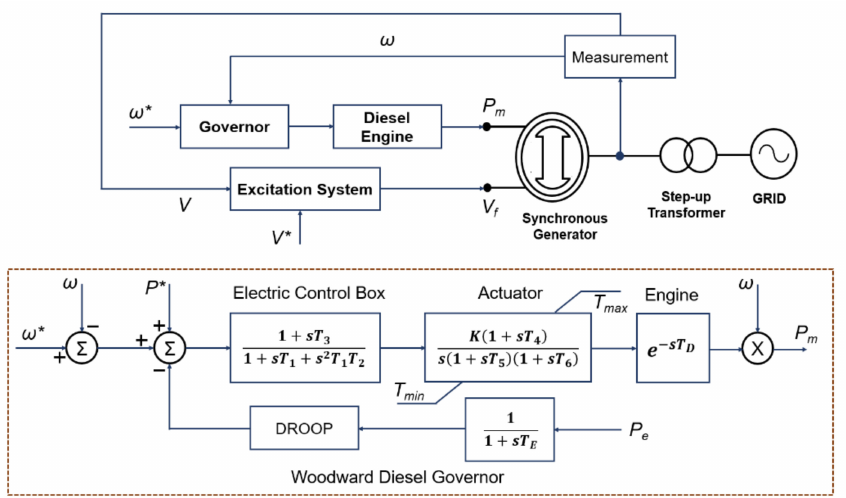
Figure 7. Simplified block diagrams of diesel generator model and its governor